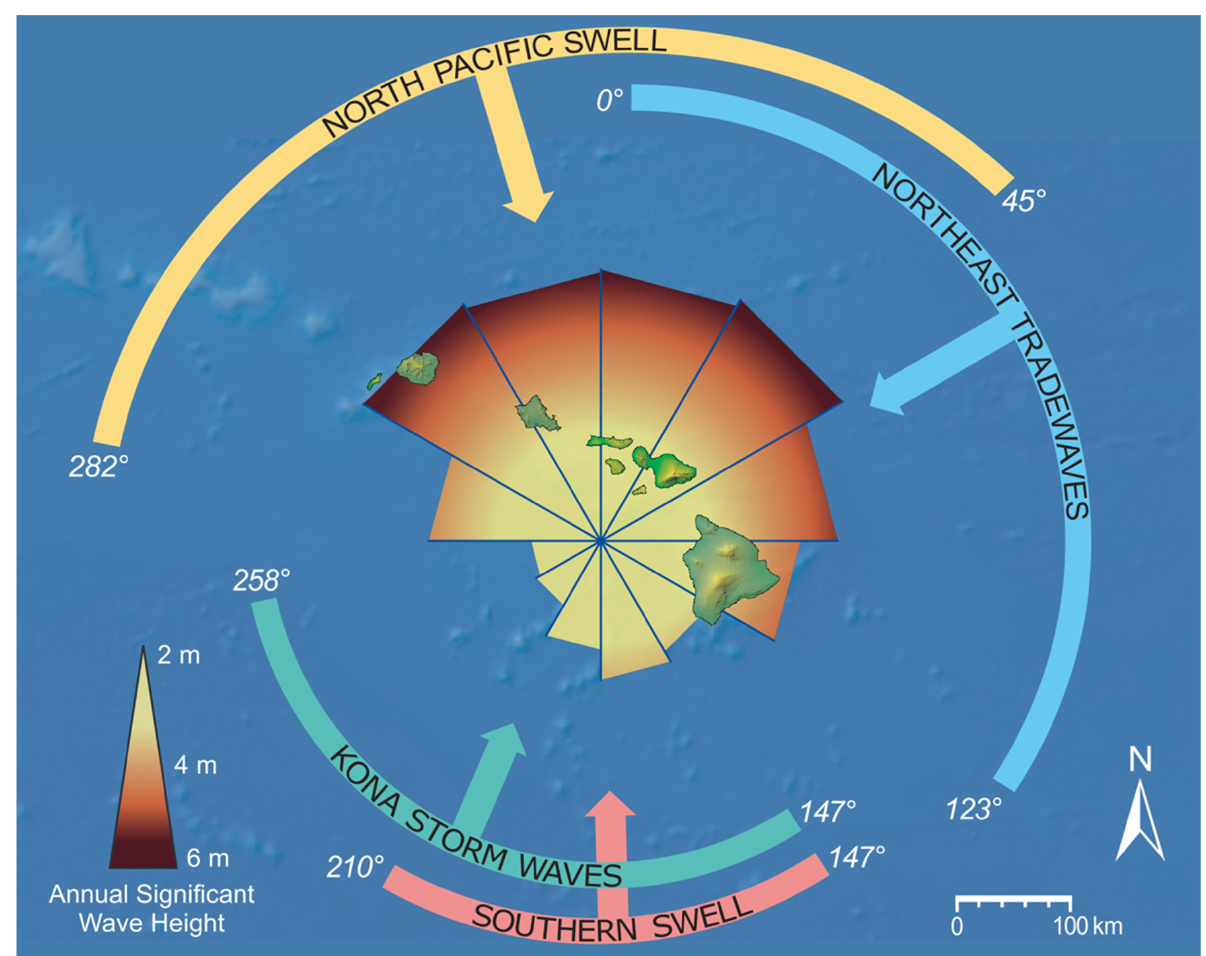
Figure 2. Dominant swell regimes for the Hawaiian Islands. Southerly swell generated by storms in the southern hemisphere represents the greatest source of wave energy to the Royal Hawaiian Beach. Occasionally, storm-generated waves can affect the Waik ī k ī area via Kona storms or tropical cyclones. Refracted wave energy due to locally generated northeasterly wind-driven waves is also capable of influencing the study site. Northerly swells, typical during the winter season, are mostly blocked by the island and have little influence on the beaches of Waik ī k ī ; however, swells with an extreme westerly or easterly direction may generate some refracted energy into the cell. Adapted with permission from ref. [49], modified after ref. [50]. Copyright 2008 Charles H. Fletcher.